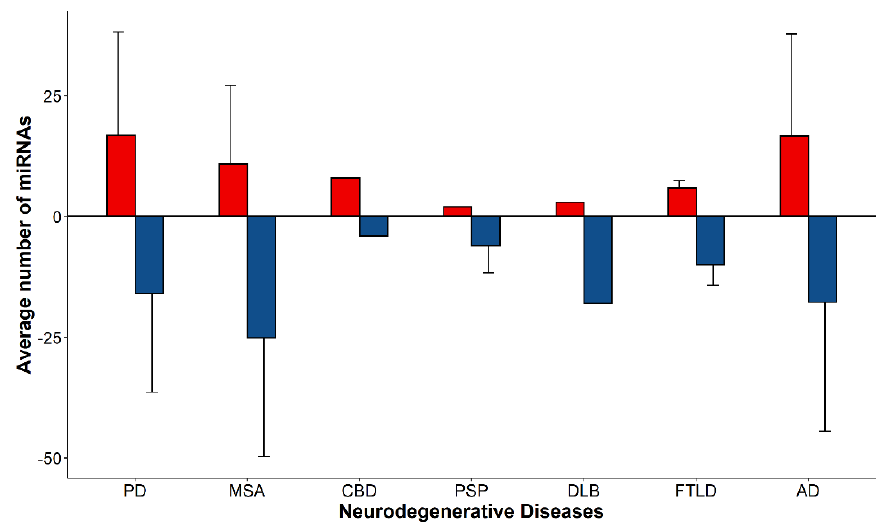
Figure 1. The average number of differentially expressed miRNAs per profile in Parkinson’s disease, multiple system atrophy, corticobasal degeneration, progressive supranuclear palsy, dementia with Lewy bodies, frontotemporal lobar degeneration and Alzheimer’s disease. A total of 17 ± 21, 11 ± 16, 8, 2, 3, 6 ± 1 and 17 ± 21 miRNAs were upregulated in PD, MSA, CBD, PSP, DLB FTLD and AD, respectively. A total of 16 ± 20, 25 ± 25, 4, 6 ± 6, 18, 10 ± 4 and 18 ± 27 miRNAs were downregulated in PD, MSA, CBD, PSP, DLB FTLD and AD, respectively. Data are represented as mean ± SD. N = 9, 8, 1, 2, 1, 2, 22 upregulated miRNA profiles, and 12, 7, 1, 2, 1, 2, 22 downregulated miRNA profiles in PD, MSA, CBD, PSP, DLB FTLD and AD, respectively. The SD observed is lowest in NDDs with fewer profiles considered.